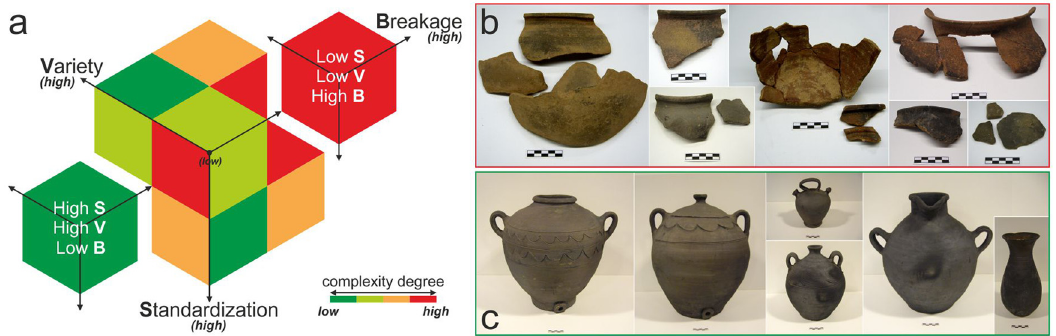
Figure 1: Degree of complexity of pottery classi fi cation according to the variability, standardization, and breakage of materials ( a ) ; assemblages with low degrees of variability and standardization together with a strong breakage are the most complex ( b ) whereas assemblages with high variability of shapes, highly standardized productions and low degree of breakage are quite easy to classify ( c )